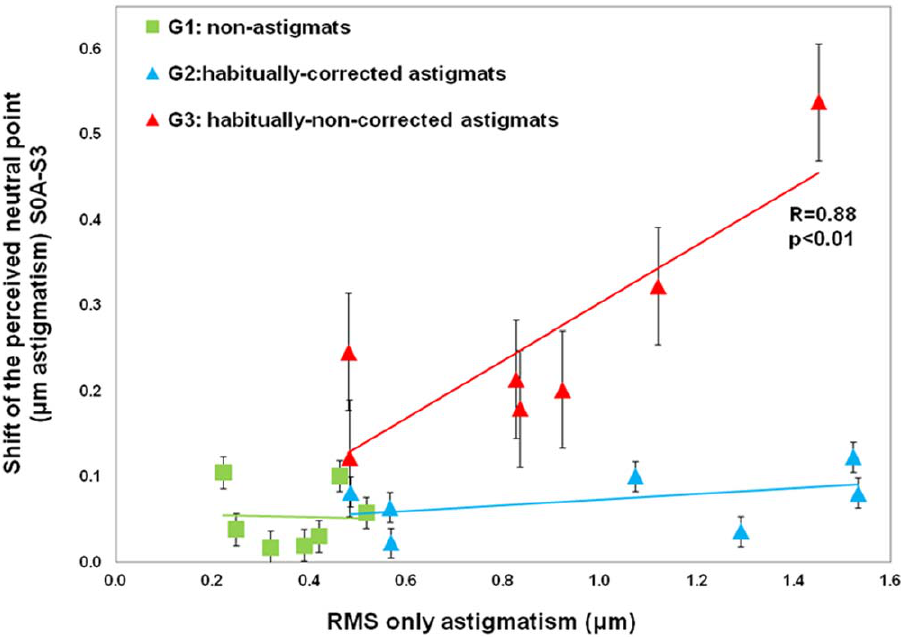
Figure 5. Correlation between the shift of the perceived neutral point and natural astigmatism of the subjects. Correlation between the shift of the perceived neutral point (difference between the perceived neutral point measured in the first session, S0A, and the 6-month session, S3) and the natural astigmatism for subjects. Astigmatism is represented in terms of RMS, in m m (G1: green squares; G2: blue triangles; G3: red triangles). Error bars stand for inter-subject variability (standard